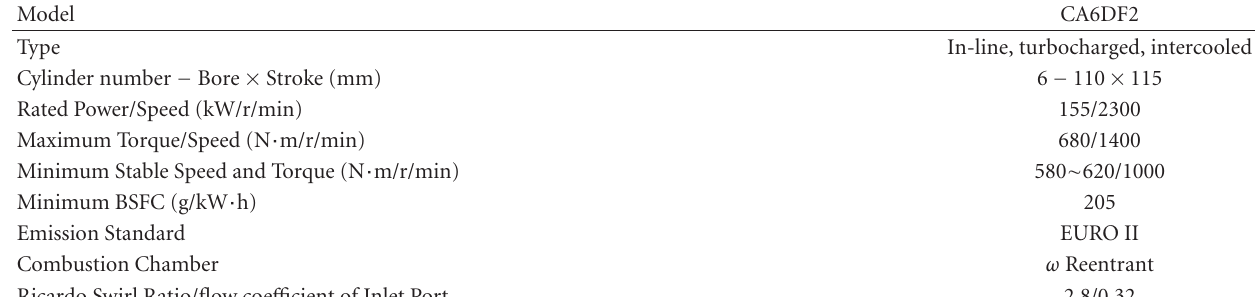
Table 1: Specifications of the original engine.